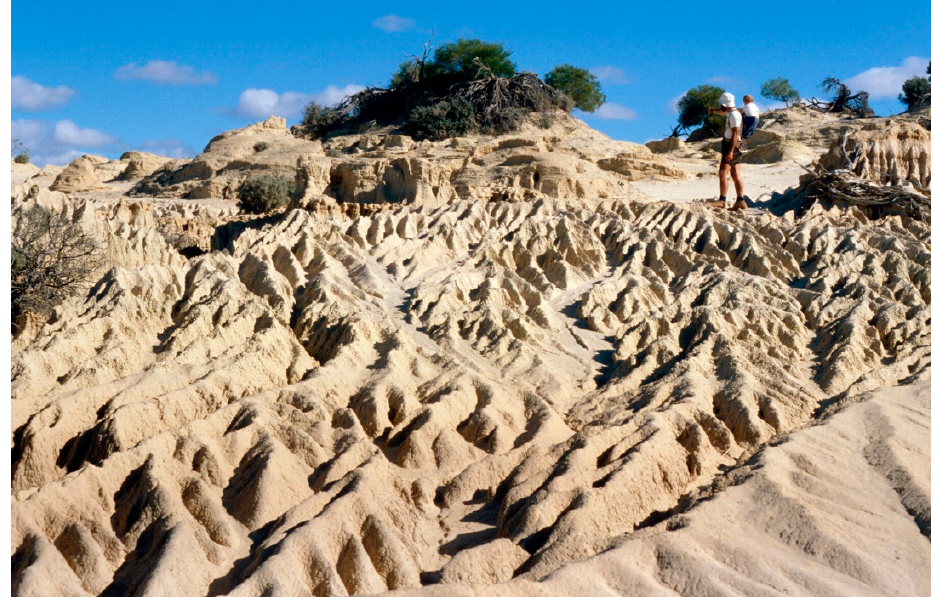
Figure A7. Eroded clay dune on the eastern margin of Pleistocene Lake Mungo.